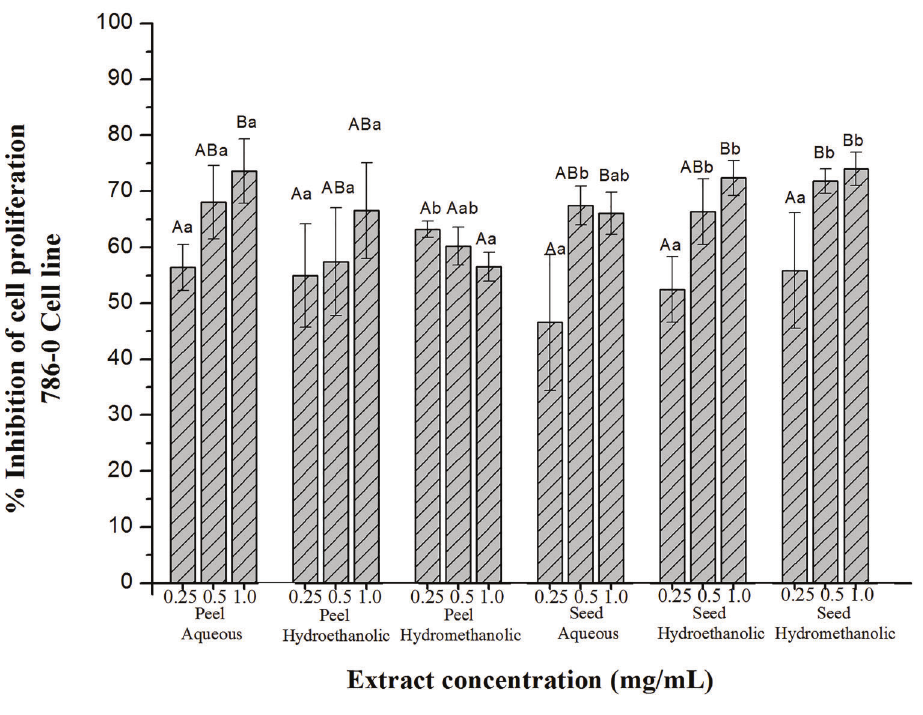
Figure 8. Effect of melon residues extracts on the inhibition of cell proliferation of the 786-0 cell line, measured by MTT test. Cells proliferation was carry out in the presence of melon residues extracts in different concentrations for 24 h. a,b,c,d Signi fi cant differences between different concentrations of the same sample. A,B,C,D Signi fi cant differences between different extracts in the same concentration (P o 0.05, ANOVA). Data are reported as means ±